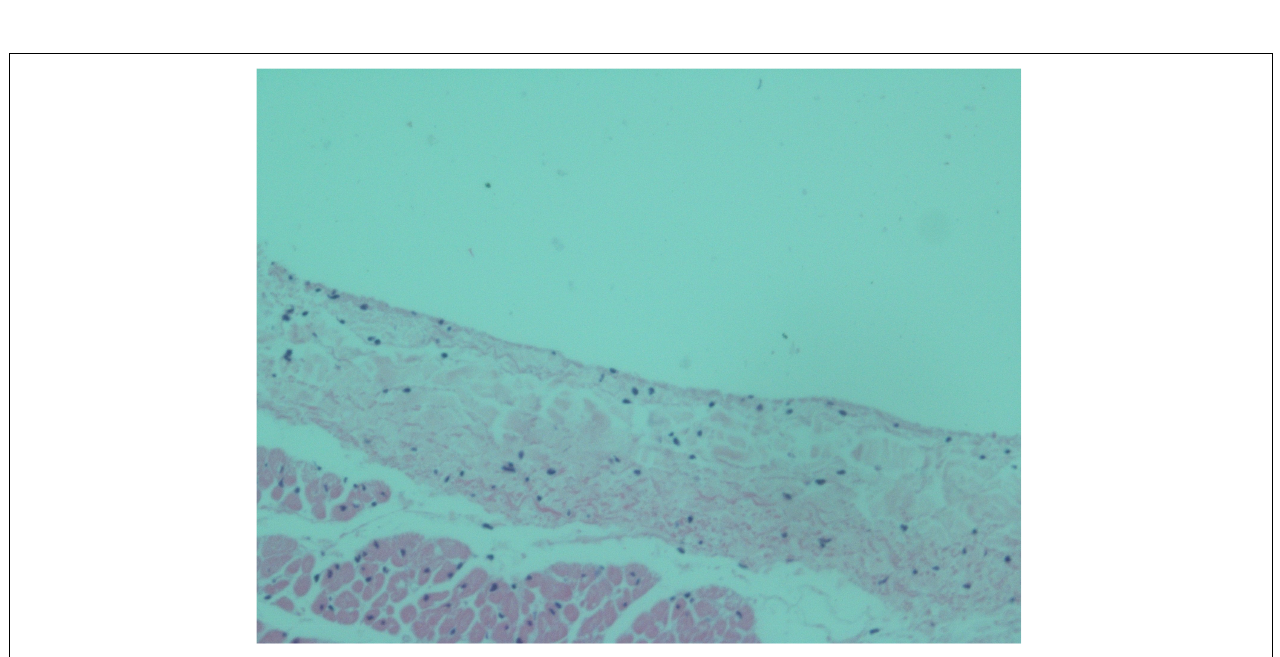
FIGURE 7 | Light microscopy view of the luminal aspect of the unexposed superior vena cava. There are intact endothelial cells.